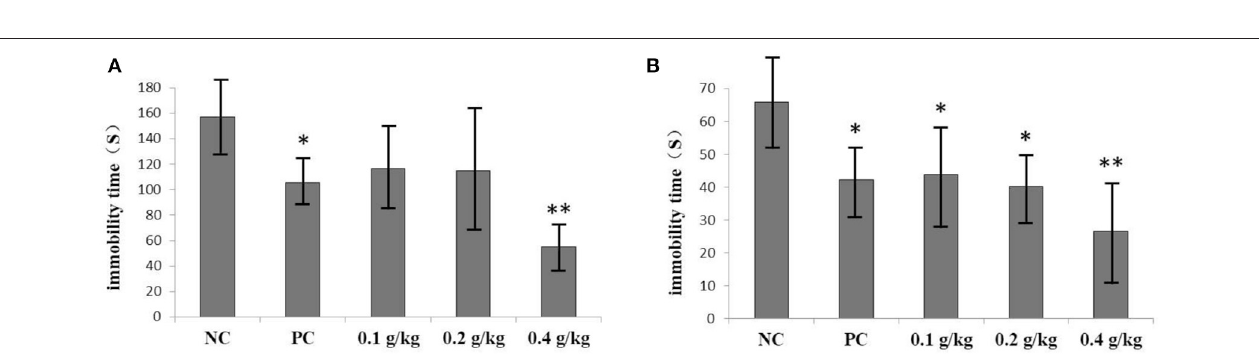
FIGURE 4 | Aroma and flavor profiles of Ganpu tea samples with different durations of sun-drying processing. The statistical analyses were performed using ANOVA, followed by LSD test (* p < 0.05, ** p < 0.01).